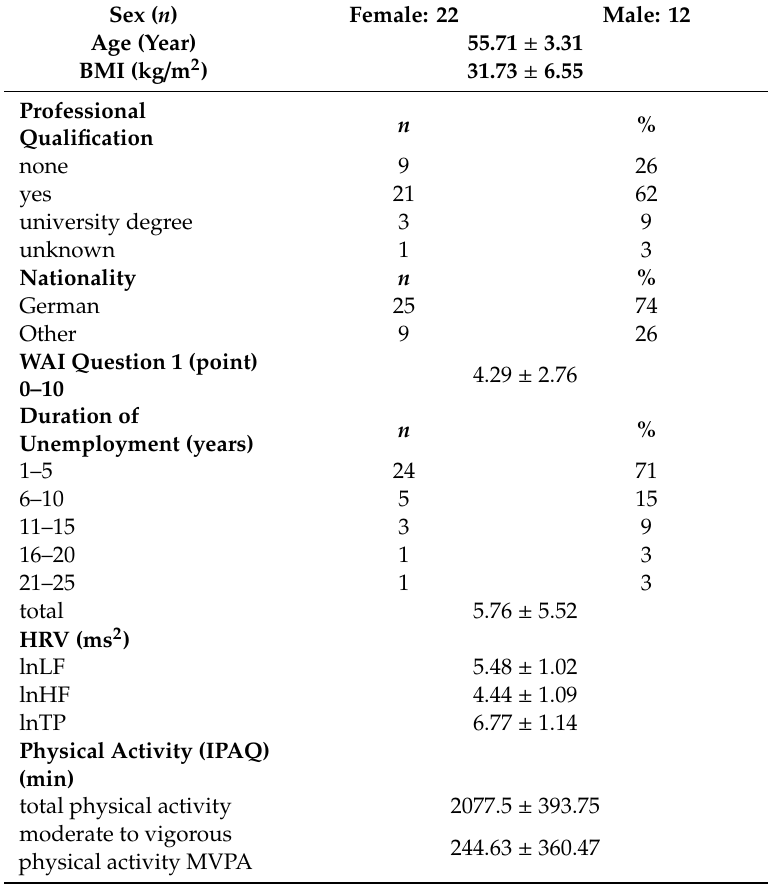
Table 1. Participants’ anthropometrics, demographics, education and duration of unemployment. If not stated otherwise, the data are displayed as the mean ± standard deviation; n (number); WAI (Work Ability Index); HRV (heart rate variability); lnLF (natural logarithm of the Low Frequency); lnHF (natural logarithm of the High Frequency); lnTP (natural logarithm of the Total Power); IPAQ (International Physical Activity Questionnaire); MVPA (moderate to vigorous physical activity). Sex ( n ) Female: 22 Male: 12 Age (Year) 55.71 ± 3.31 BMI (kg / m 2 ) 31.73 ± 6.55 n